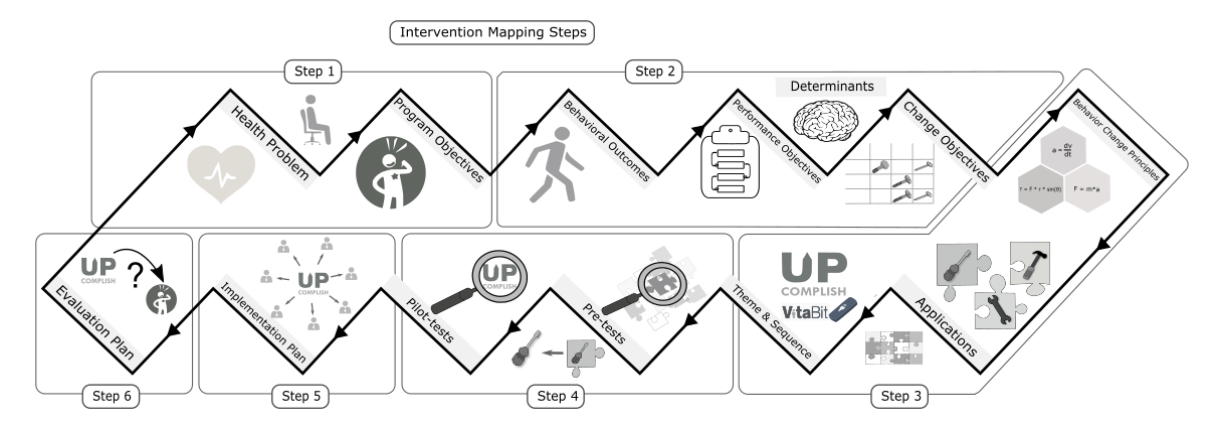
Figure 1. Overview of the steps and products in the intervention mapping